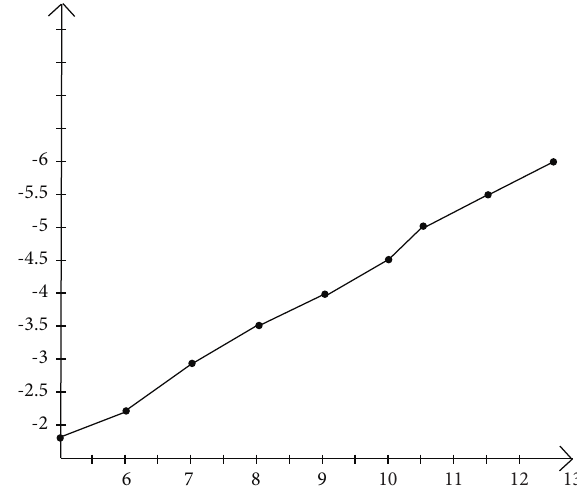
Figure 2: The behavior of eigenvalues with respect to number of